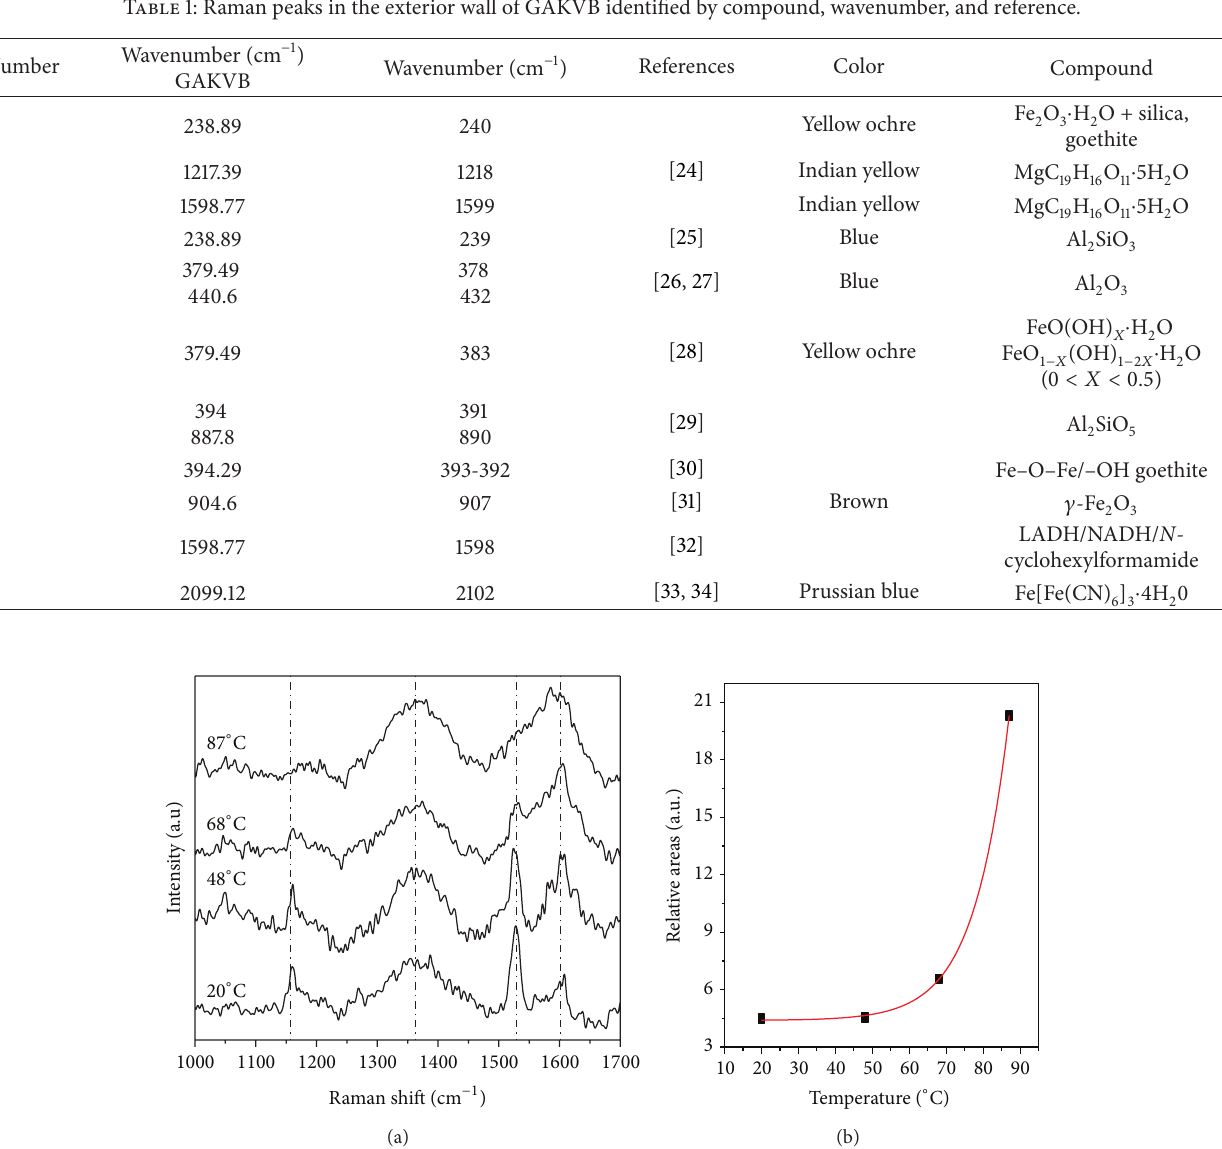
Table 1: Raman peaks in the exterior wall of GAKVB identified by compound, wavenumber, and reference.